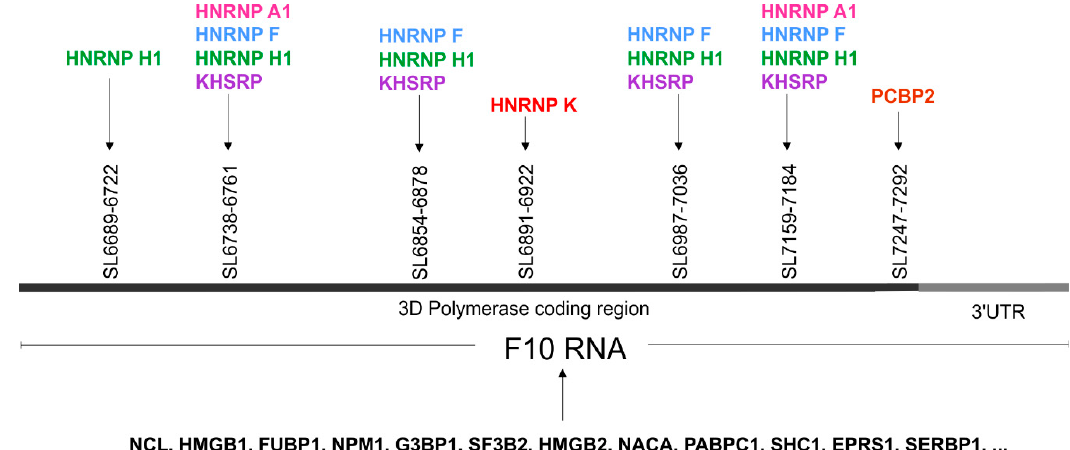
Figure 6. The proteins identified in the RNA-centric affinity chromatography that were found to be interacting with F10 RNA fragment from the 3 ′ -terminus of the CVB3 genome. Possible localizations of the RNA–protein interactions for several proteins is given, based on the presence of a predicted sequence binding site (ATtRACT database) within the F10 sequence. The figure shows the gene names rather than full protein names to minimize the space required. Different colors represent distinct proteins.